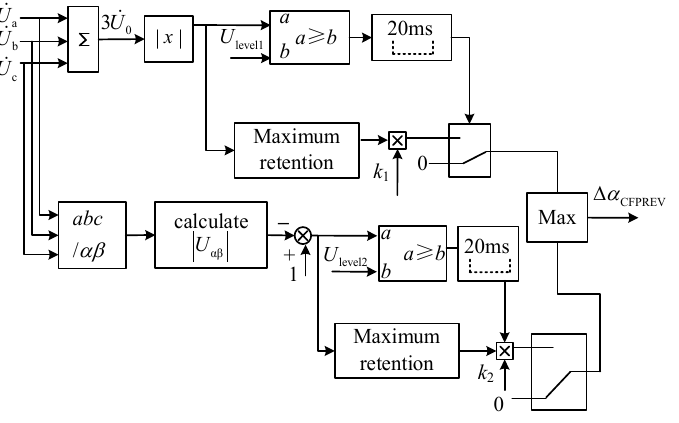
Figure 7. Schematic diagram of CFPREV control.